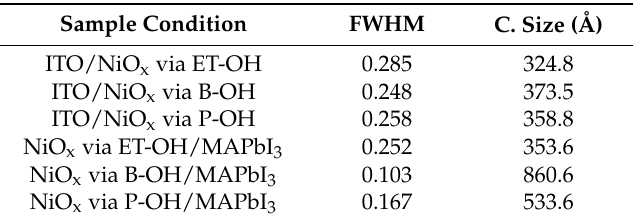
Figure 4. XRD patterns of MAPbI 3 on ITO/NiO x substrate via solvent (ET-OH, B-OH, and P-OH). Table 2. Crystallite size with FWHM (Full Width at Half Maximum) on ITO/NiO x via solvents and ITO/NiO x via solvents/MAPbI 3 substrate.